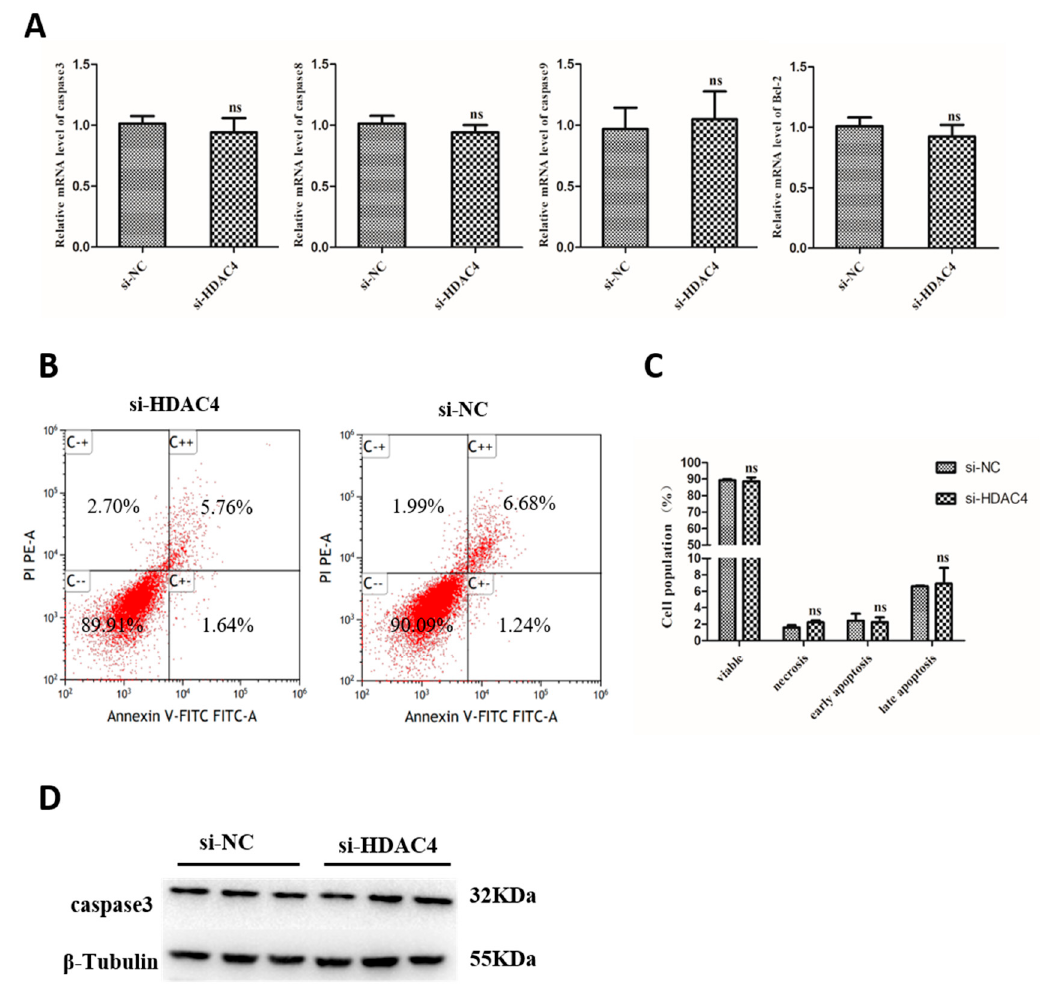
Figure 5. Knockdown of HDAC4 has no effect on the apoptosis of chicken SMSCs. ( A ) The mRNA level of caspase 3, caspase 8, caspase 9, and Bcl-2 was determined by qPCR in SMSCs after being transfected with si-HDAC4 and si-NC. ( B , C ) Flow cytometry for cell apoptosis analysis of SMSCs at 48 h after transfection with si-HDAC4 and si-NC. ( D ) The protein expression level of caspase 3 was determined by western blotting in SMSCs after being transfected with si-HDAC4 and si-NC. In all panels, the values represent mean ± SEM from three independent experiments. * p < 0.05; ** p < 0.01.